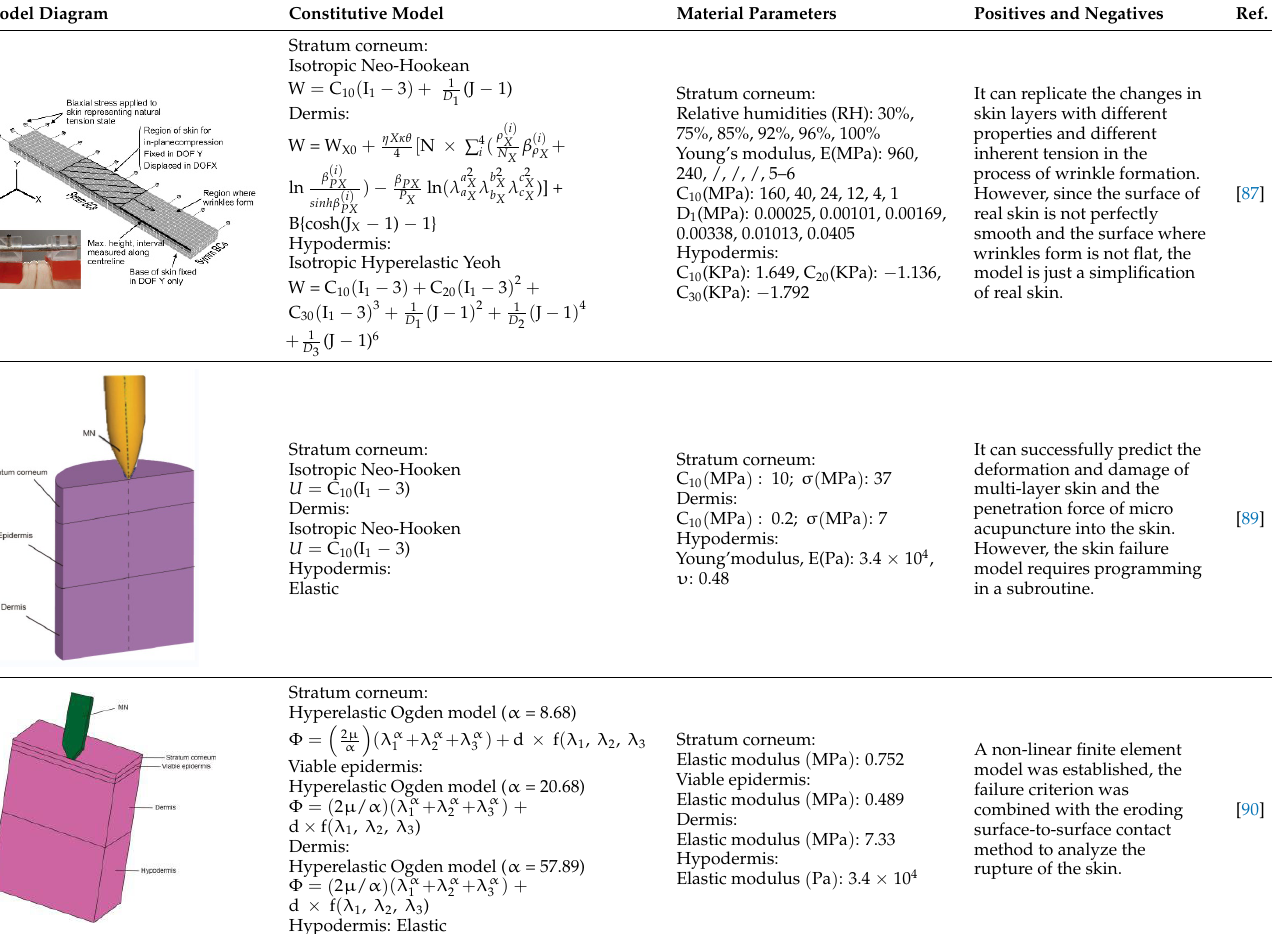
Table 2. Different skin constitutive models (Reprinted with permission from Ref. [87]. Copyright 2010, Elsevier. Reprinted with permission from Ref. [88]. Copyright 2017, Elsevier). Model Diagram Constitutive Model Material Parameters Positives and Negatives Ref. Stratum corneum: Isotropic Neo-Hookean Stratum corneum: Relative humidities (RH): 30%, 75%, It can replicate the changes in skin layers with different properties and different inherent tension in the process of wrinkle formation. However, since the surface of real skin is not perfectly smooth and the surface where wrinkles form is not flat, the model is just a simplification of real skin.